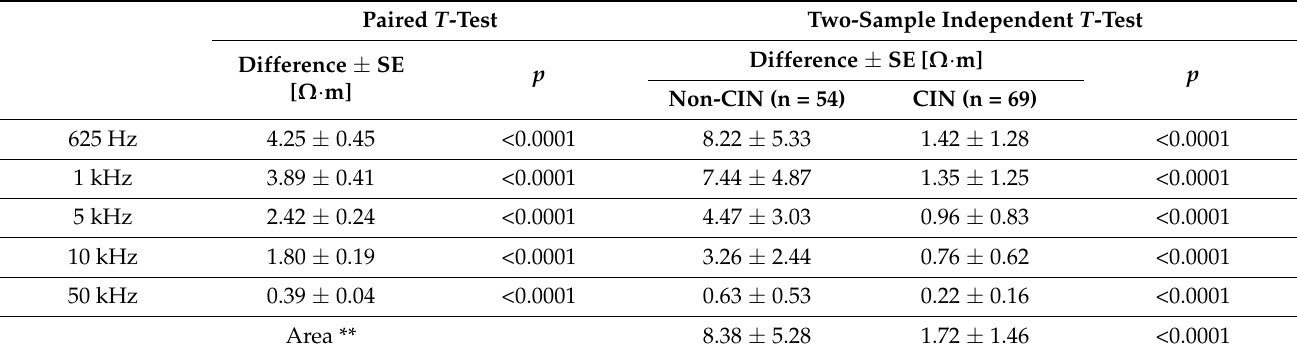
Table 3. Difference in reconstructed resistivity relative to 100 kHz of cervical tissues from the non-CIN and CIN groups. Paired T -Test